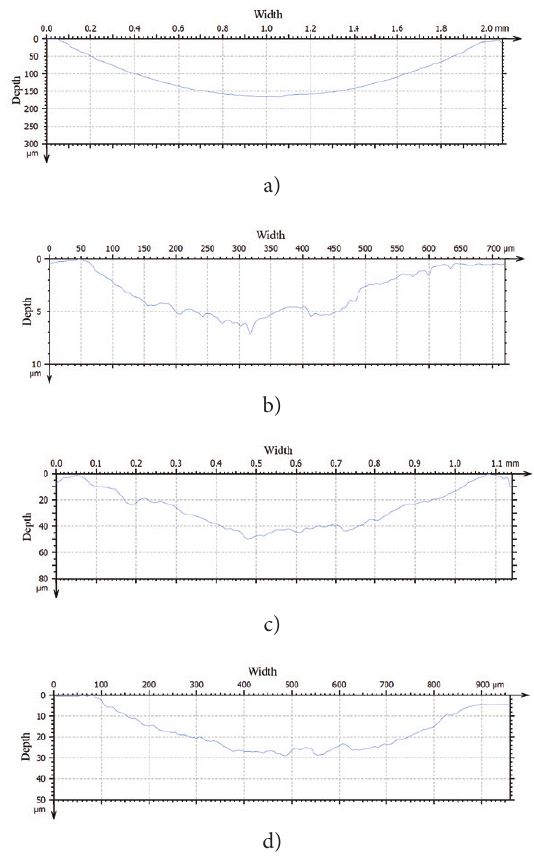
Figure 7. Cross-sections through the friction path for materials: